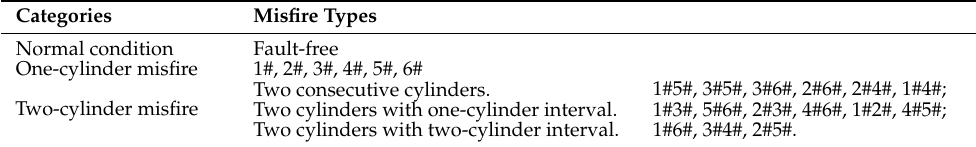
Figure 2. Engine operating conditions. Table 2. All the misfire types.